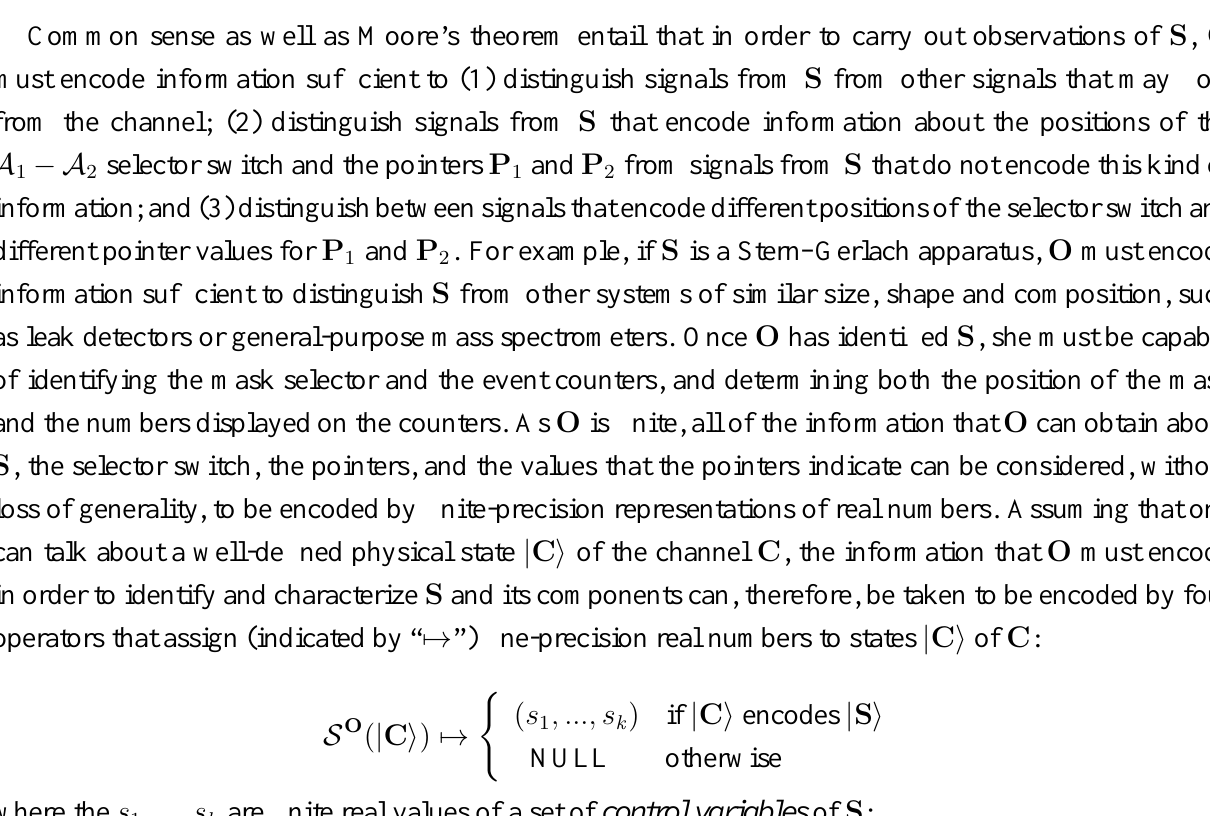
Figure 2. A macroscopic system S with the observable